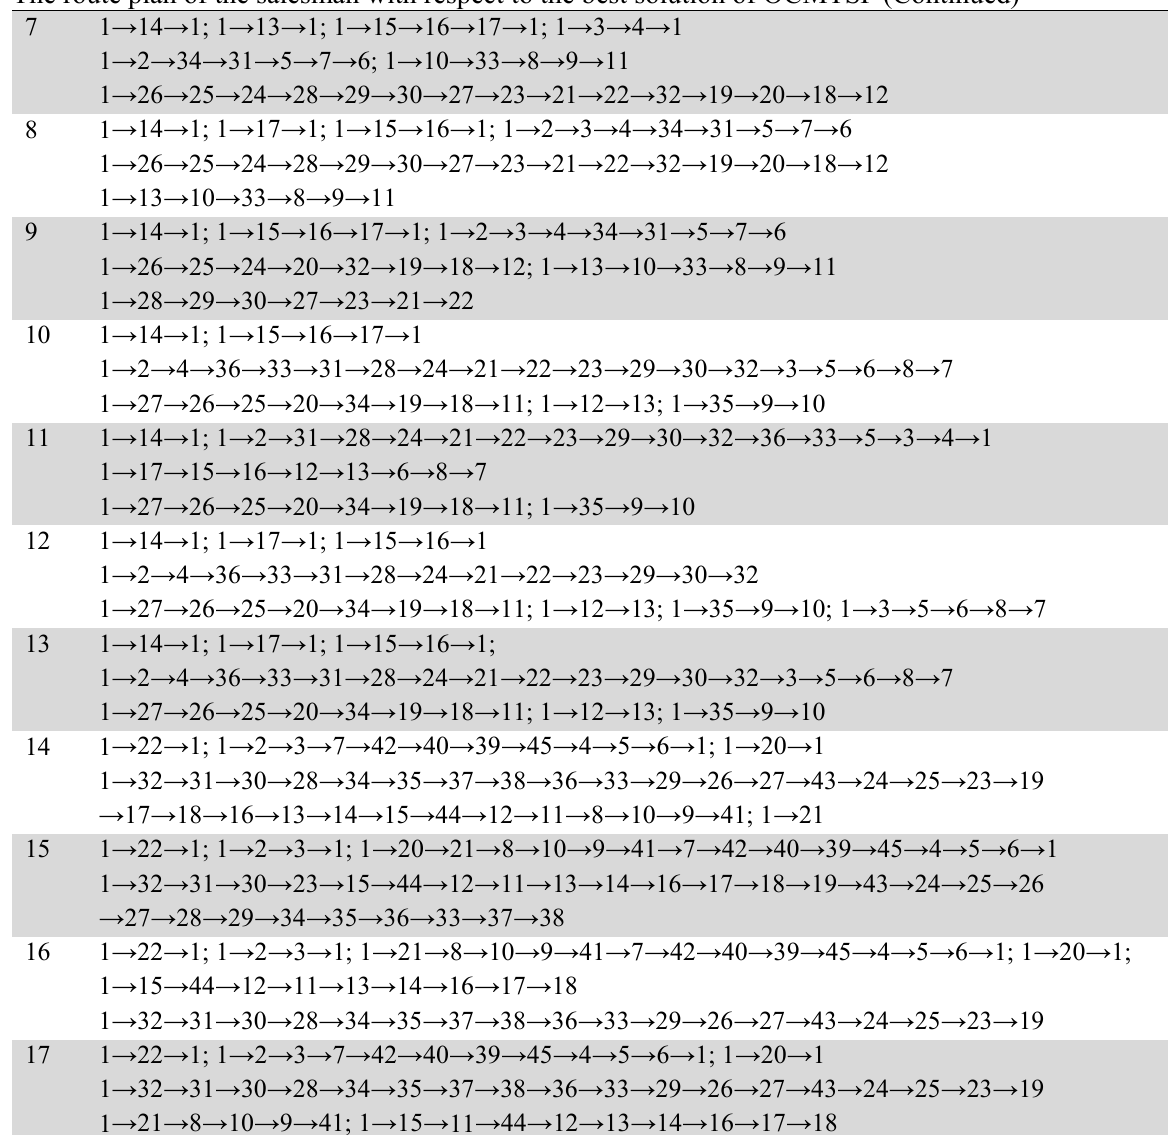
The route plan of the salesman with respect to the best solution of OCMTSP (Continued)